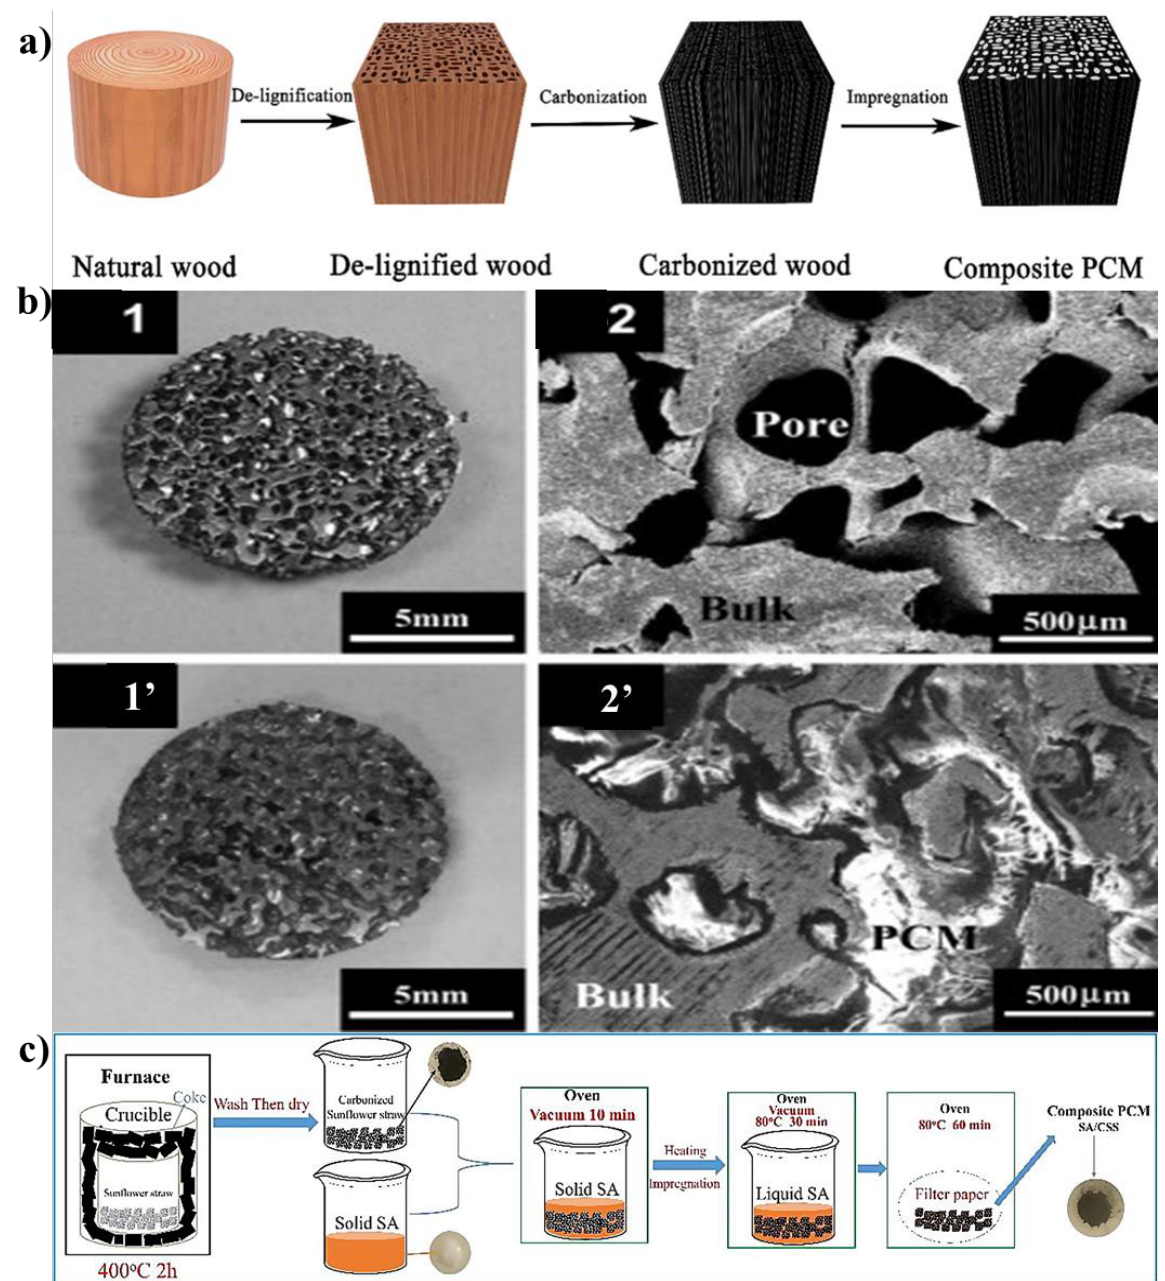
Figure 8. ( a ) Preparation of LA/PCWs ss-CPCMs illustration. ( b ) (1) and (2) are the SEM pictures of porous nickel before vacuum impregnation, and (1′) and (2′) are the SEM pictures of porous nickel after vacuum impregnation. ( c ) The experimental procedure for manufacturing SA/CSS composite PCM.